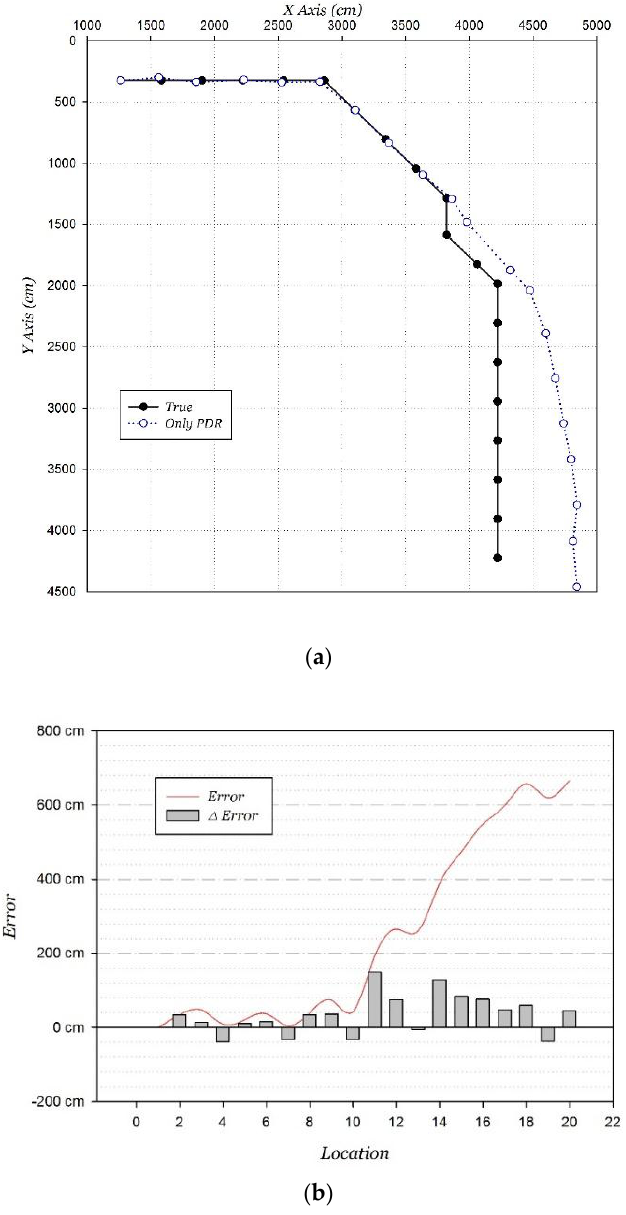
Figure 17. PDR positioning. ( a ) Distribution; ( b ) error distribution.